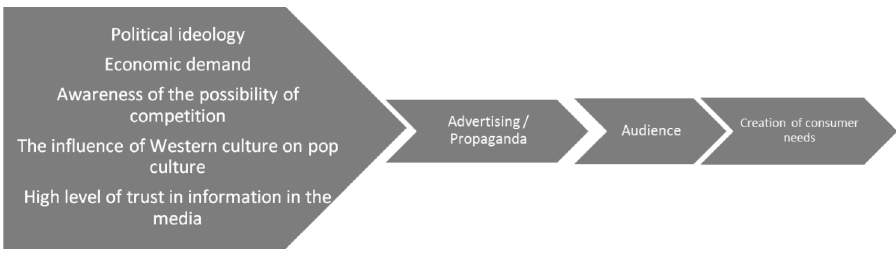
Figure 8. Hybrid model of economic propaganda